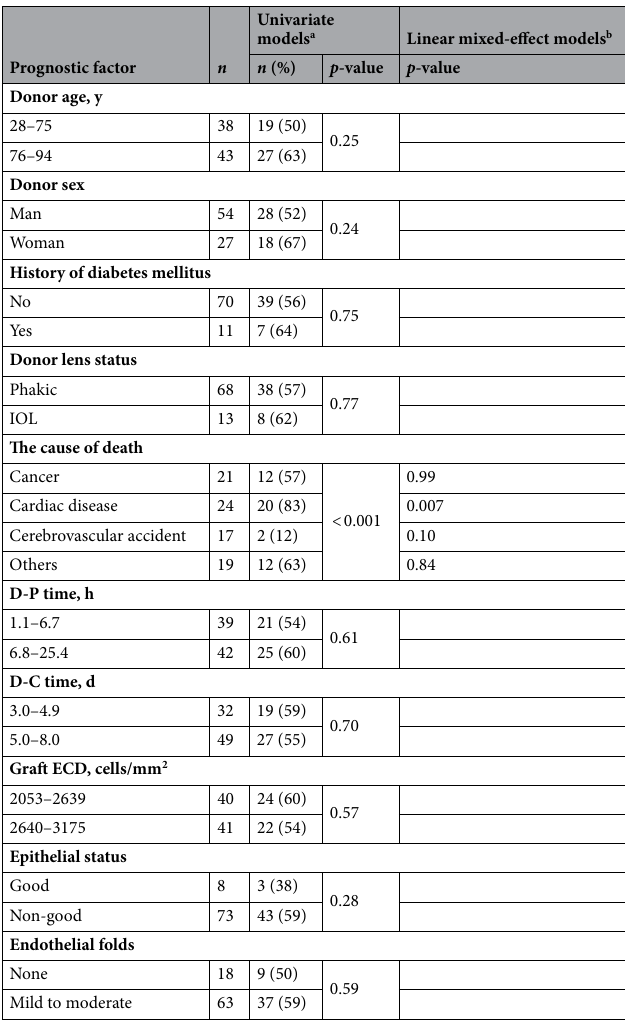
Model 7: death from cardiac disease, microkeratome 400-head size;